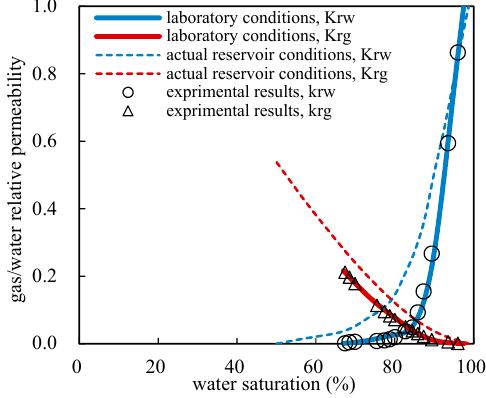
Figure 18. Gas/water relative permeability curves of core 43 # .